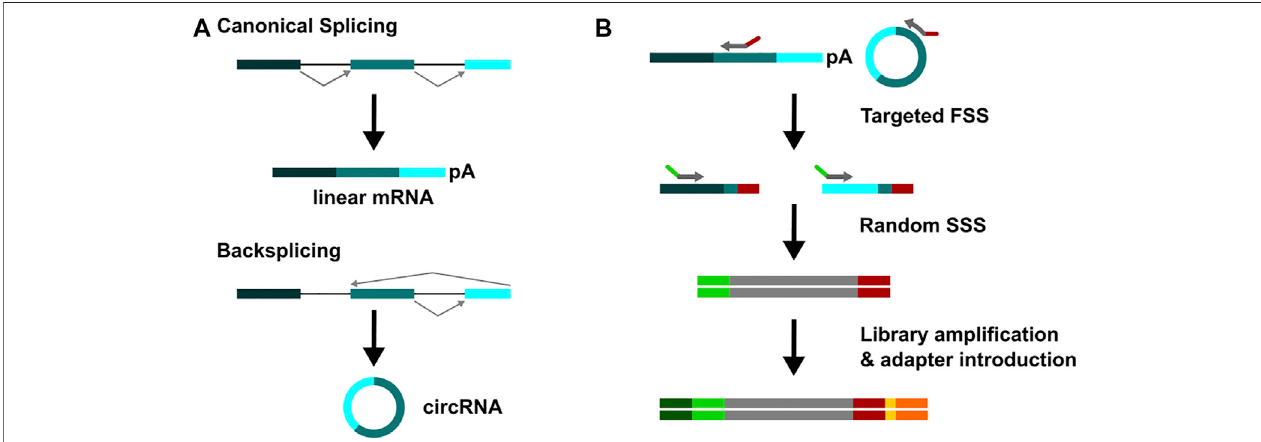
FIGURE1| OverviewofLexo-circSeqlibrarypreparation. (A) Upperpanel:ThecanoncialsplicingresultsingenerationoflinearmRNAs.Lowerpanel:circRNAsare generated in a process called back-splicing. (B) Total RNA issubjected totargeted First Strand Synthesis (FSS) employing primers directed against up to110 circRNAs and their corresponding linear transcripts. Random Second Strand synthesis (SSS) enables detection of all 5 ’ exons. During library preparation, adapters and indices (yellow) for Illumina sequencing are introduced. Here, only one index was used, but dual indexing may be applied as